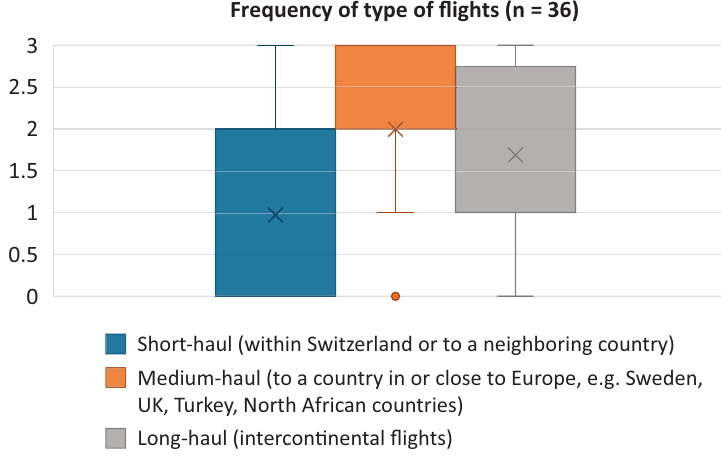
Figure 3. Flying frequency by type of flight for the workshop